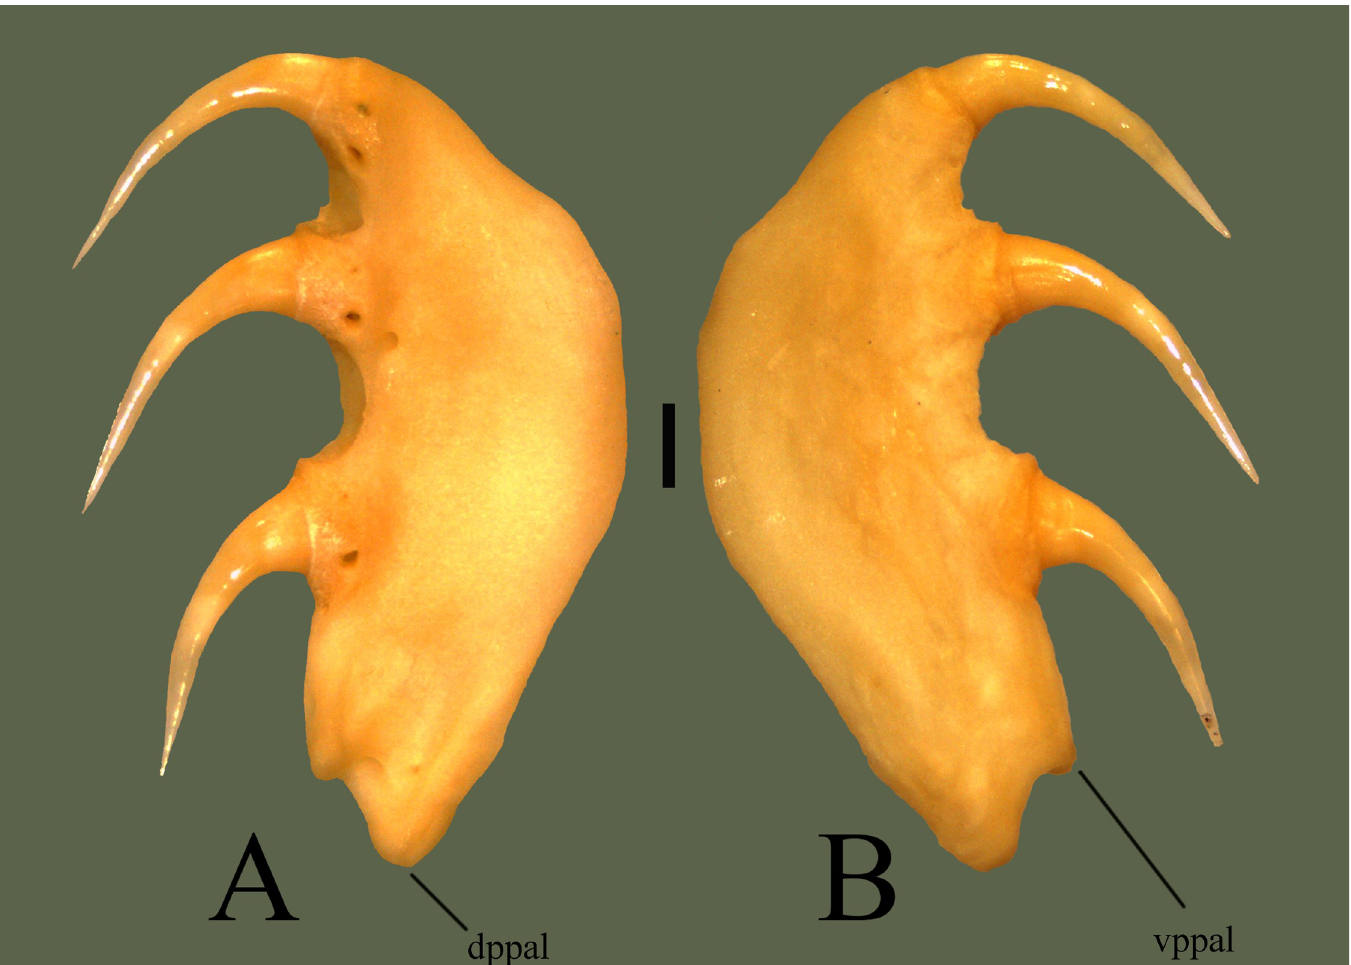
Fig 7. Right palatine (ETVP 3295) in medial (A) and lateral (B) view . Anterior is to the top. Scale bar = 1mm. Abbreviations: dppal = dorsal process of palatine; vppal = ventral process of palatine.